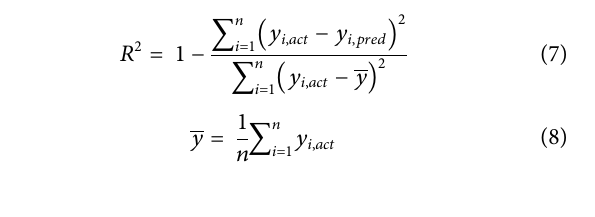
shows all the parameters used to reduce computation time.